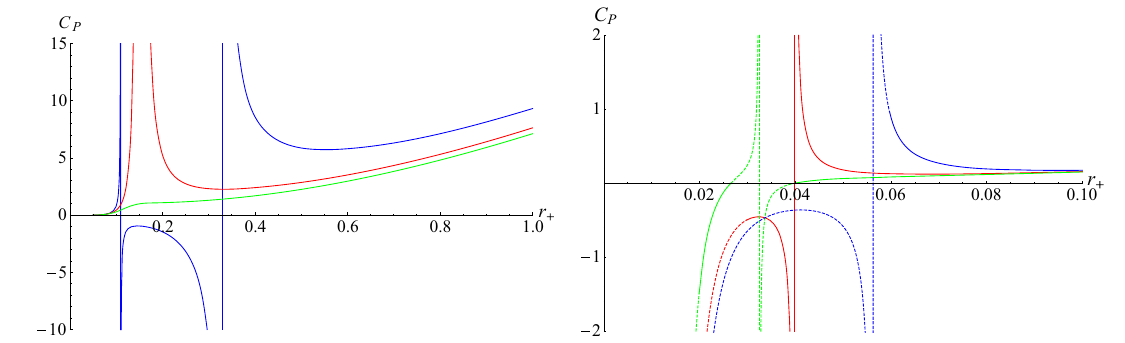
Fig. 8 Plots of the heat capacity for the positive effective horizon cur- vature (left) and the zero one (right). Left panel: the blue, red and green curves correspond to P = 0 . 5, 1 . 1353 ( P c ), 2, respectively, at m = c = c 1 = c 2 = 1 and k = 0 . 1. Right panel: the blue,